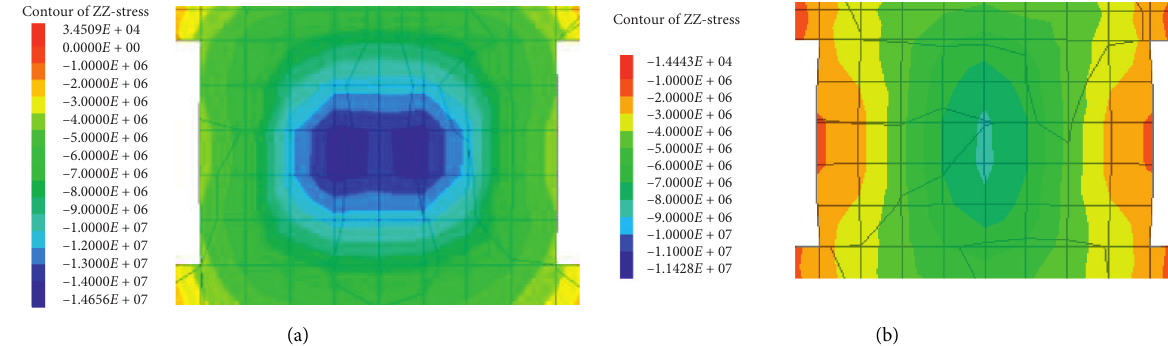
Figure 5: The vertical stress distribution before and after the room pillar was damaged. (a) Before the room pillar was damaged. (b) After the room pillar was